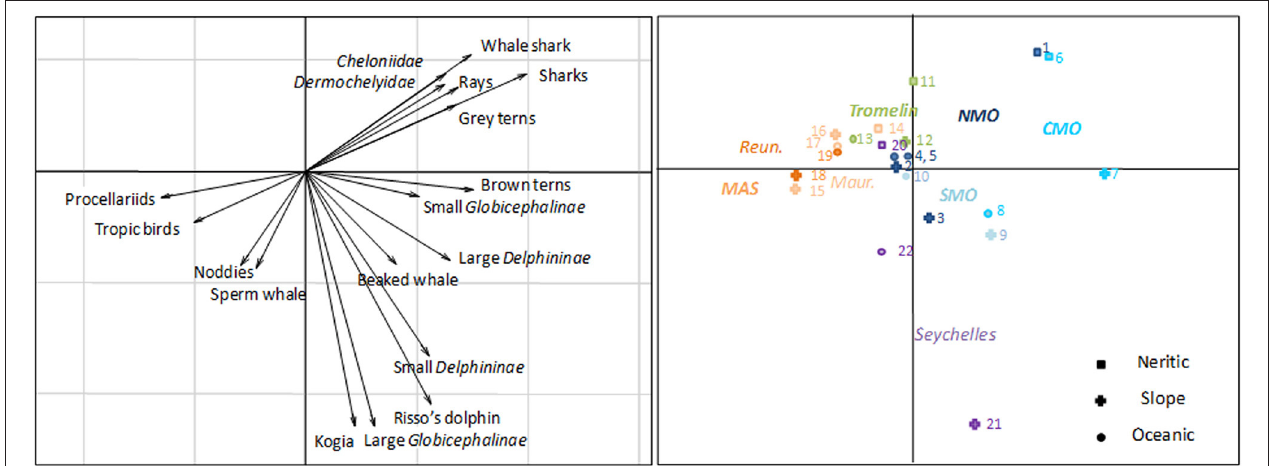
FIGURE 5 | Result of the first two axes of the Principal Component Analysis obtained with the densities of 18 groups of megafauna over 22 different strata (see Figure 1 for strata codes) in the survey area of the SW Indian Ocean.